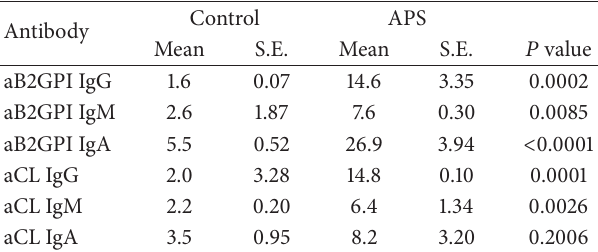
two months 3 patients (1.9%), and prolonged immobility 1 patient (0.6%).